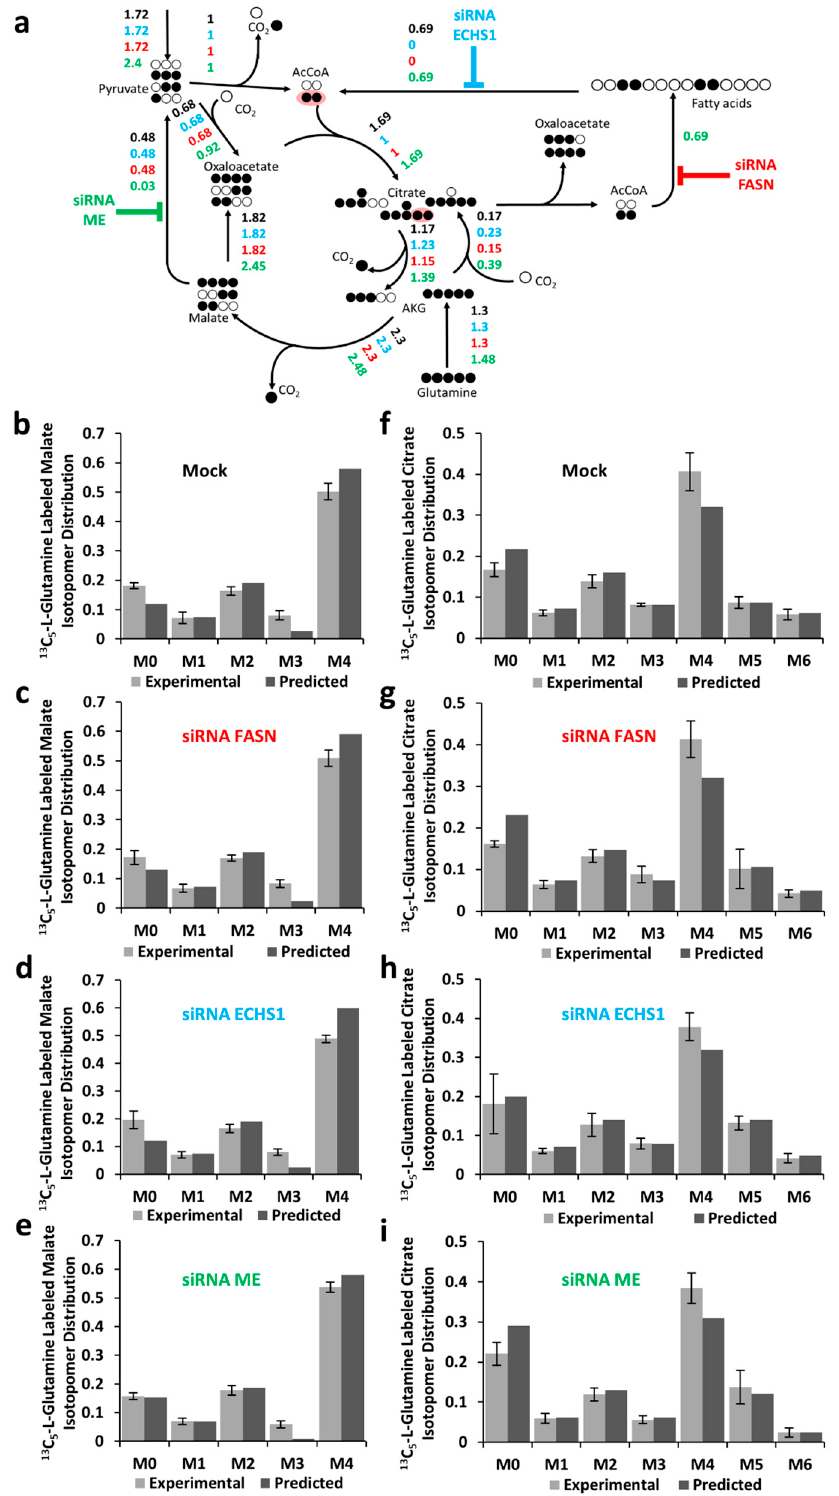
Figure 2. Estimated metabolic flux distributions and isotopomer distributions (simulated and experimental) of malate and citrate for BCC cells. ( a ) Metabolic model with atomic transitions and estimated flux distribution for the mock (black) and siRNAs against FASN (red), ECHS1 (cyan), and ME (green) transfected BCC cells. ( b – e ) Malate and ( f – i ) citrate isotopomer distribution in mock and siRNAs against FASN (red), ECHS1 (cyan), and ME (green) transfected BCC cells. The bar plots show the fractions of citrate and malate labeled in zero (M0) to six (M6) carbons. Error bars represent 95% confidence intervals (n = 4).